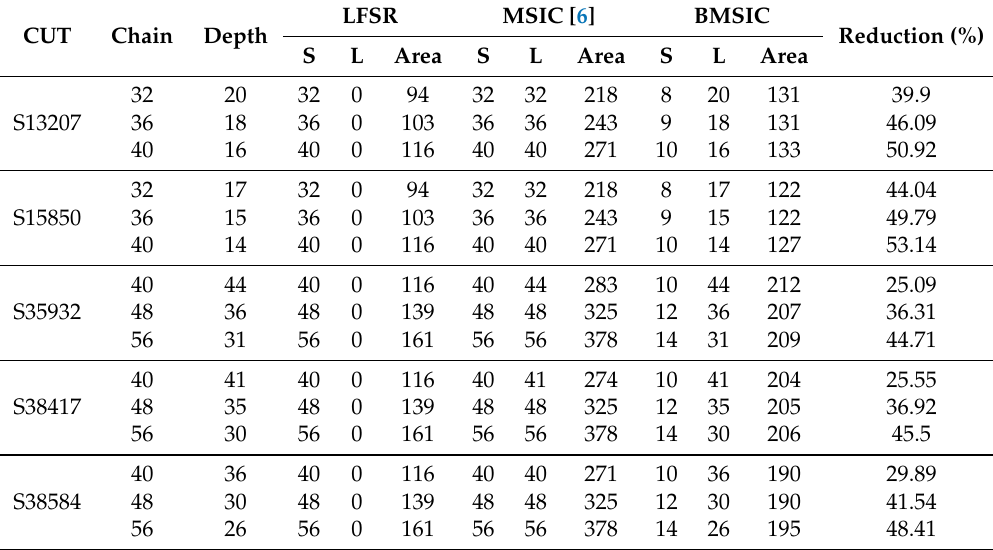
Table 4. Area Overhead Comparison of the three test generation